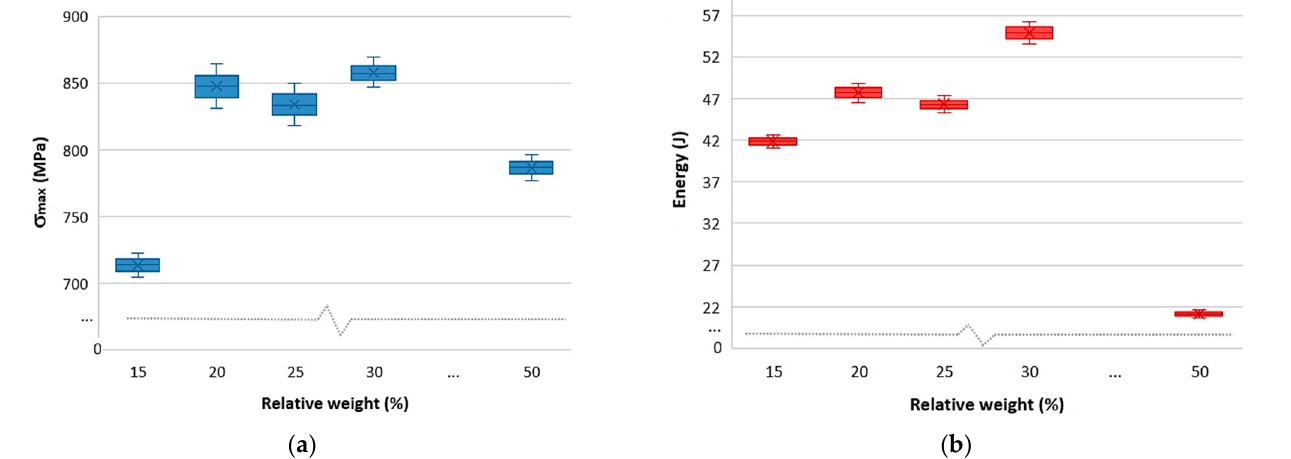
Figure 11. Measured values with standard deviations of ( a ) the maximum stress and ( b ) energy absorption for individual relative weights of the Neovius samples.